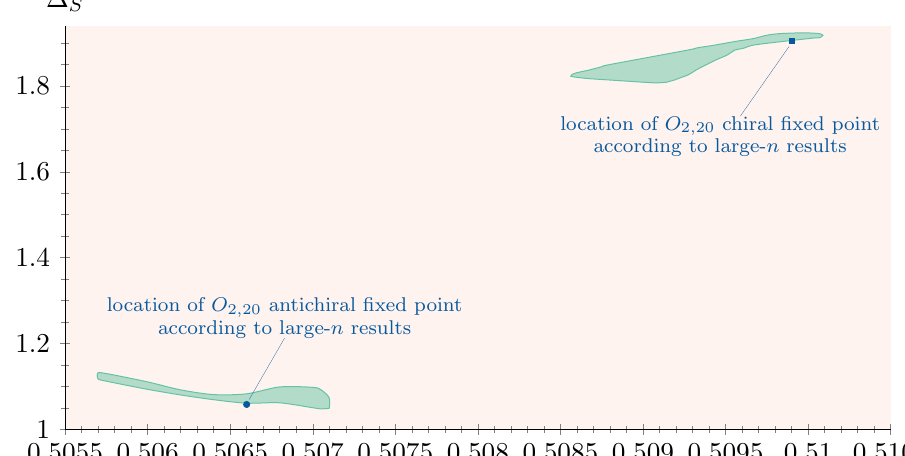
Figure 7: Allowed region (in green) for the O their location according to (8). The chiral island is obtained with the assumptions (C-1)-(C-5), while the antichiral island is obtained with the assumptions (A- O (A- O 2,20